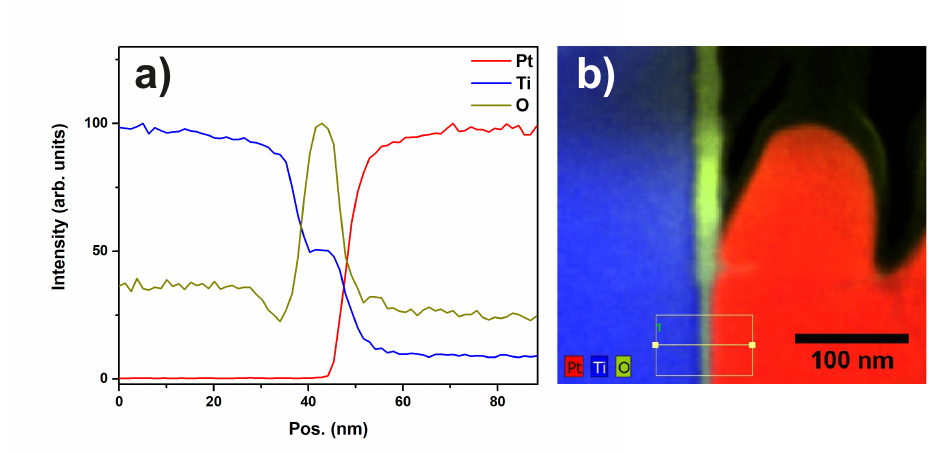
Figure 11. ( a ) EDX linescan of sample “Au/Pt” showing the signal intensities of the Pt, Ti and O peaks. The FWHM of the O signal indicates a thickness of 10 to 20 nm for the oxide layer; ( b ) STEM-EDX map showing the edge of a Pt particle, the oxide layer, and the Ti support. Additionally, the marker indicates the region from which the linescan was